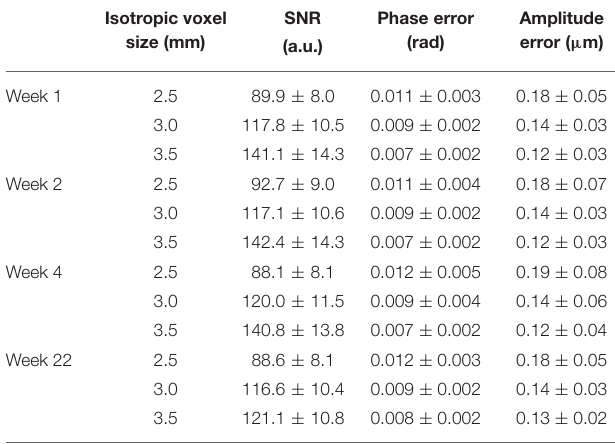
TABLE 3 | Calculated SNR and corresponding phase and amplitude errors within the phantom for the MRE datasets at different resolutions and measurement timepoints post fabrication.